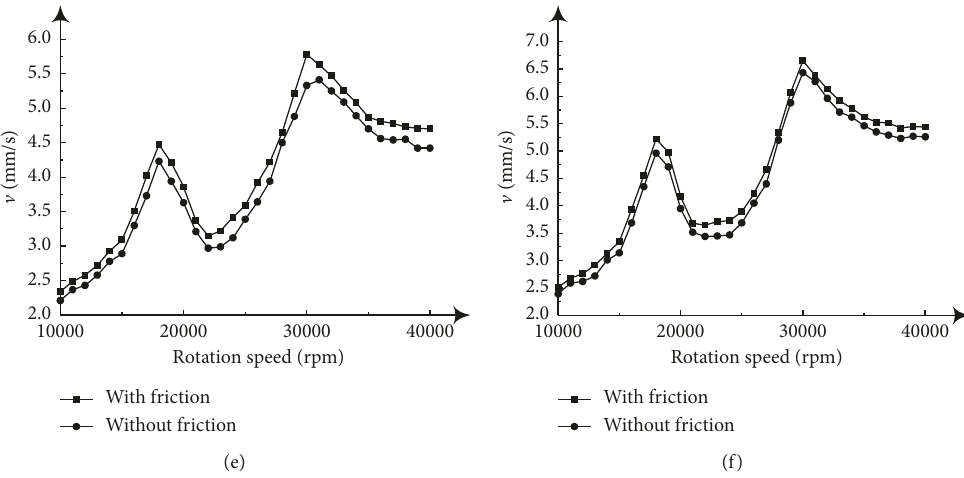
Figure 16: Results with and without friction at (a) T � 100K, (b) T � 200K, (c) T � 300K, (d) T � 400K, (e) T � 500K, and (f) T �